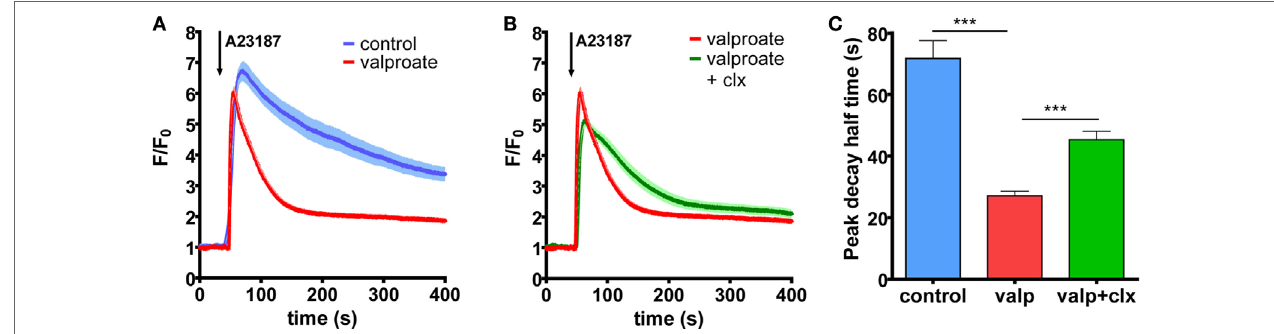
FigUre 4 | histone deacetylase inhibitor treatment increases ca 2 + clearance in BraF-mutant a375 cells through PMca4b activity . (a) Ca 2 + signaling measurement was performed after 48 h of treatment with 2 mM valproate. External media were changed to HBSS supplemented with 2 mM Ca 2 + , and cells were filled with intracellular Ca 2 + indicator, Fluo-4. The Ca 2 + signal was initiated by 2 µM A23187. (B) The PMCA4-specific inhibitor, caloxin 1c2 (20 mM) was added 10 min before stimulation with A23187 to the valproate-treated cells. Data represent fluorescent intensity values of 10–15 cells. (c) Half-peak decay time of the A23187-induced Ca 2 + signal was determined after treatment with valproate alone or in combination with the PMCA4 inhibitor, caloxin 1c2, compared to control. Bar graphs are mean ± SD of individual cells taken from two to three independent experiments. Significance between control and valproate- or vemurafenib-treated cells is denoted by *** p < 0.001; two-tailed unpaired t